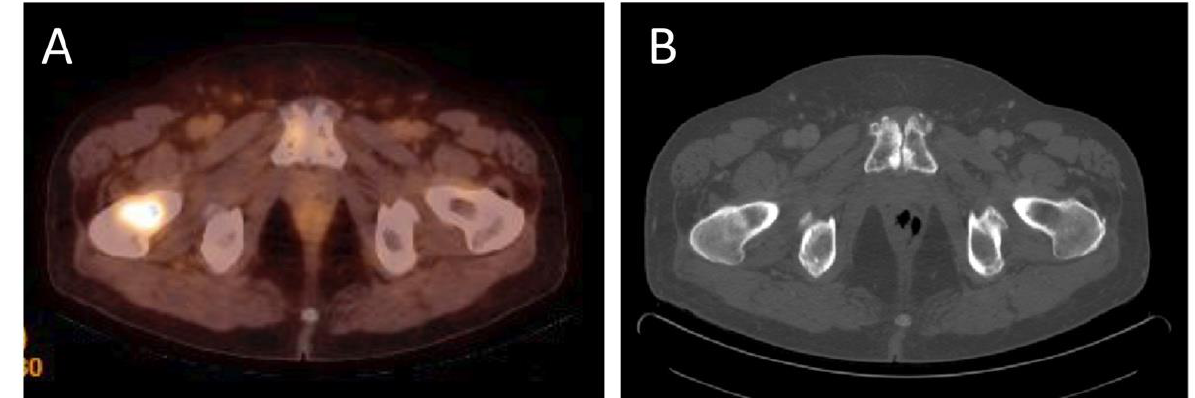
Figure 3. ( A )— 18 F-PSMA-1007 PET/CT examination of a patient (69 years old) after radical Figure 3. ( A ) — 18 F-PSMA-1007 PET/CT examination of a patient (69 years old) after radical prosta- tectomy seven years before, current PSA level 3.9 ng/mL. 18 F-PSMA-1007 uptake in the right femur with SUVmax = 5.7 was detected to approve metastatic activity. ( B ) in computed tomography mild, local sclerotic lesion in the right femoral neck was inconclusive (Images from Riga Stradins Univer- sity Radiology research laboratory archive).